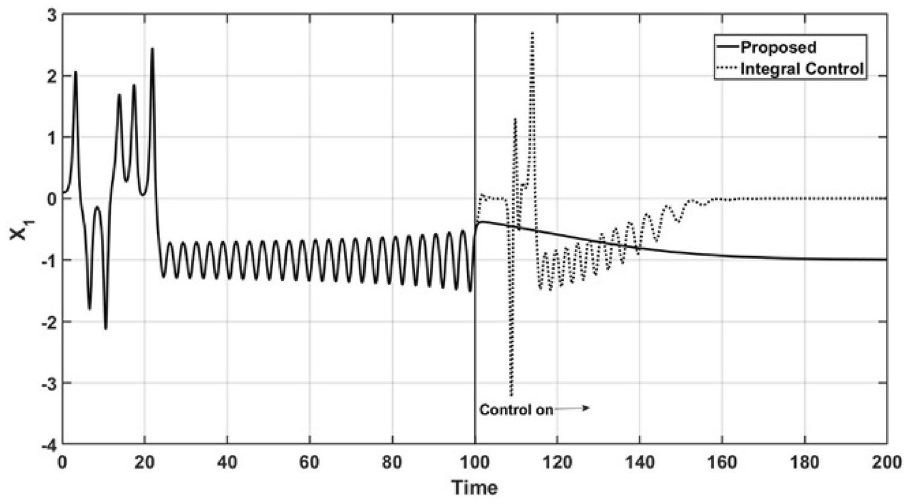
Figure 2. Trajectories of the uncontrolled variable x 1 .